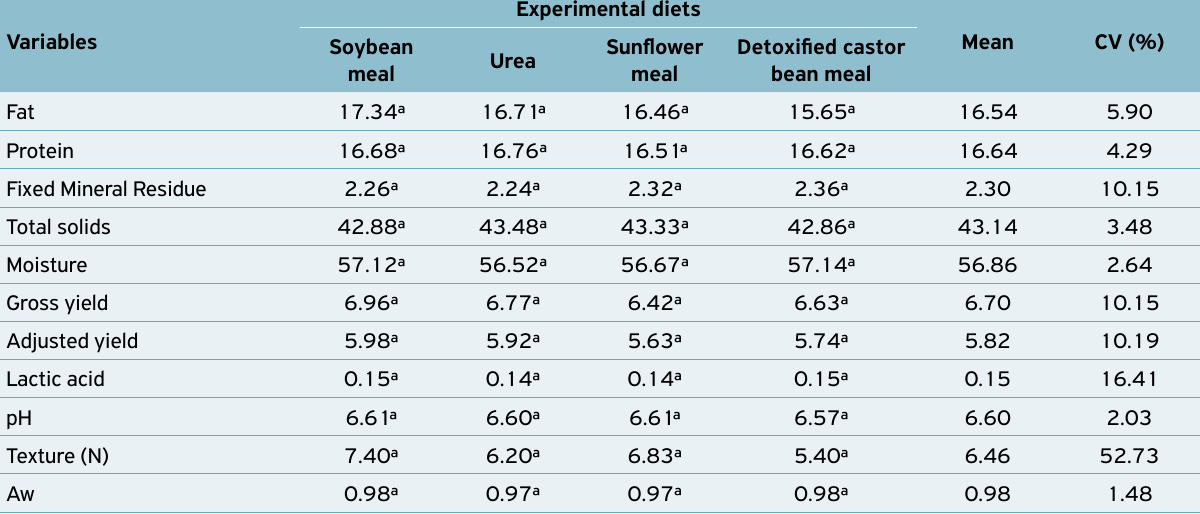
Table 3. Physical and chemical composition (%), gross yield (kg/kg) and moisture-adjusted yield (kg/kg) of Minas fresh cheese made with milk from F1 Holstein/Zebu cows fed diets containing different sources of nitrogen compounds, with respective mean values and coefficients of variation